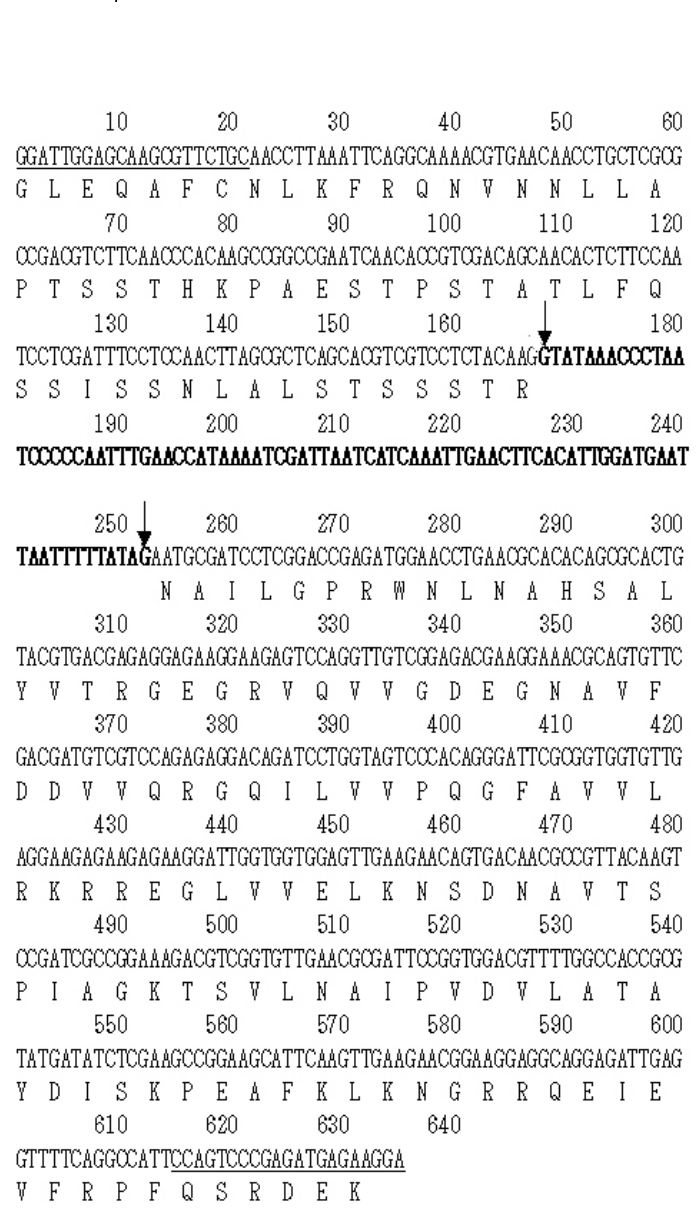
FIGURE 5. Nucleotide and deduced amino acid sequences of the genomic DNA encoding the 22-kDa protein in F. gracilipes . The primer pairs used to amplify the genomic DNA are underlined. The intron sequences are indicated by bold letters. The arrows indicate the characteristic GU..AG dinucleotide combinations of the intron